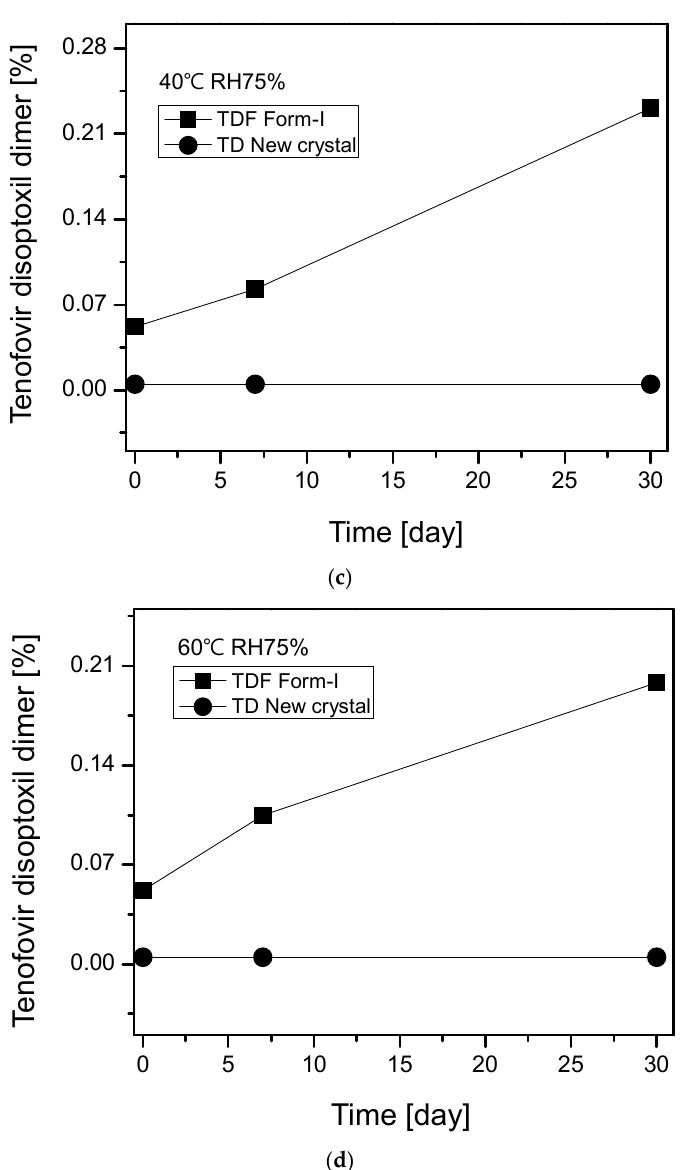
Figure 7. Comparative evaluation of the storage stability of and TD dimer formation from TD free base crystal and TDF Form-I under accelerated and stress conditions. ( a ) Storage stability at accelerated condition (40 °C, RH 75%), ( b ) storage stability at stress condition (60 °C, RH 75%), ( c ) TD dimer formation at accelerated condition (40 °C, RH 75%), ( d ) TD dimer formation at stress condition (60 ° C, RH 75%).